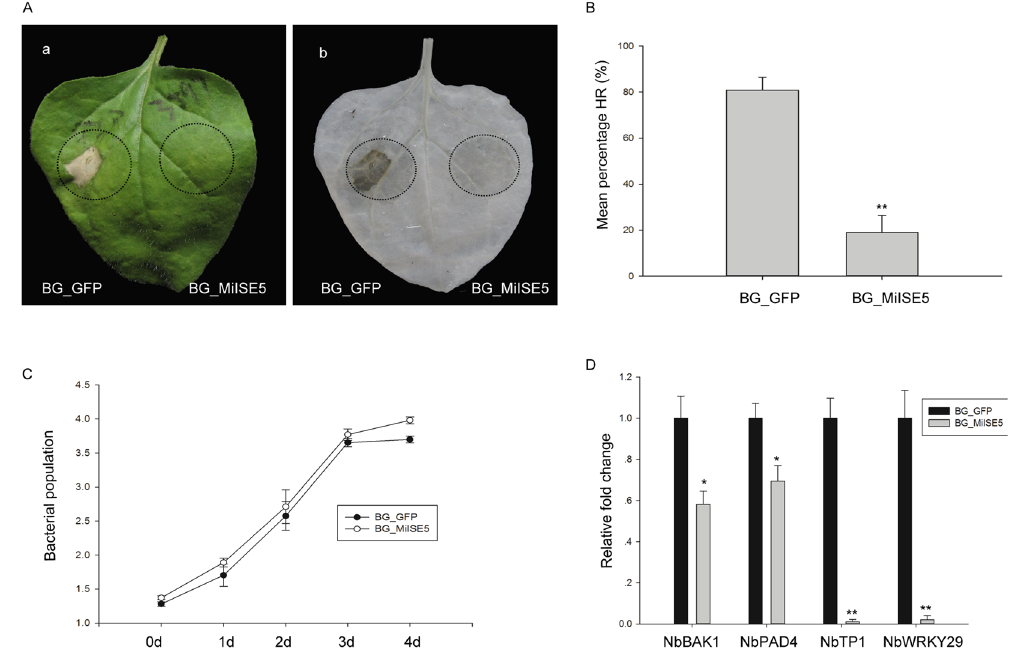
Figure 2. MiISE5 suppresses B. glumae induced cell death and basal defense responses. ( A ) The N. benthamiana leaves were photographed within 3 days after B. glumae inoculation (a) and then cleared in ethanol (b) to observe the cell death symptoms. The left half leaf sections were injected with B. glumae carrying pEDV::GFP and the right half section were injected with B. glumae carrying pEDV::MiISE5. ( B ) The average areas of cell death lesions of control GFP and MiISE5. ( C ) Bacterial population [log 10 ·(CFU cm − 2 )] in BG_GFP and BG_MiISE5. Bacteria were recovered from inoculated leaves 1–4 days after inoculation. ( D ) Expression of plant defense genes. The expression level of NbBAK1, NbPAD4, NbTP1, NbWRKY29 were measured by q-PCR in BG_GFP and BG_MiISE5 inoculated leaves at 24 dpi. The actin gene was used as an internal control. Each bar represents the mean ± SD of three independent biological replicates, and the mean values significantly different from the control are demoted by * as determined by an independent samples t -test ( * P < 0.05, ** P <